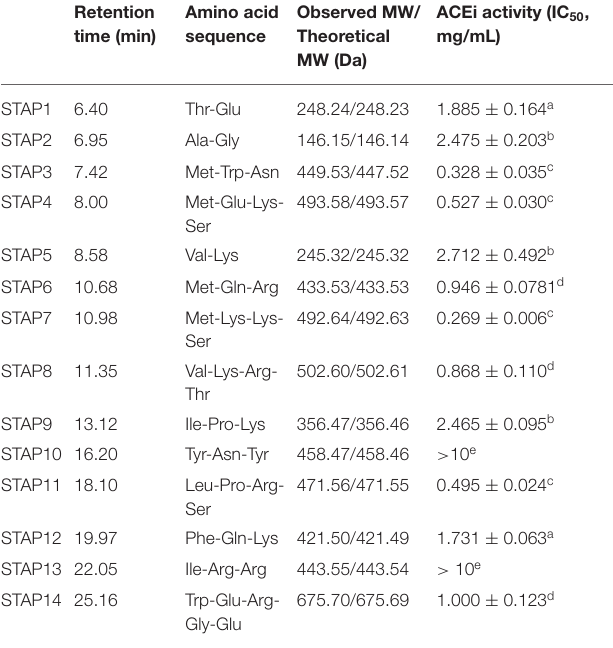
TABLE 3 | Amino acid sequences, molecular weights (MWs), and ACEi activity (IC